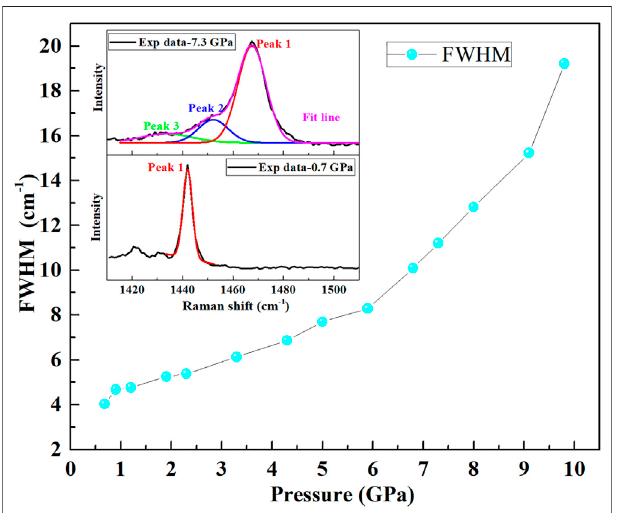
FIGURE 3 | Variation of FWHM ( ν 21 vibration mode) with pressure.